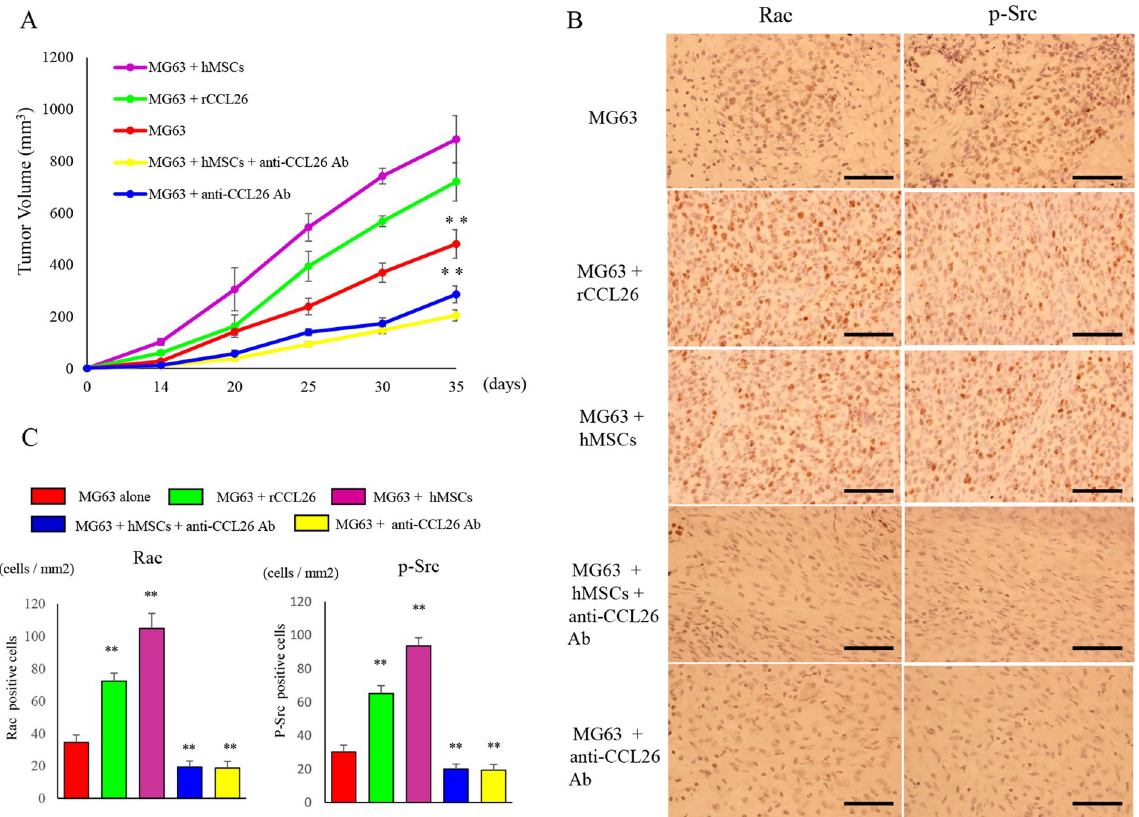
Figure 6. Changes in the lung nodules and the expression of Rac and phosphorylated Src in pulmonary metastatic lesions. ( A ) The group given anti-CCL26 Ab showed a significant suppression of the size of the pulmonary metastatic lesion. ( B ) Immunostaining of the tissues collected from the pulmonary metastatic lesion. Decreased expression of Rac and p-Src was observed in the group administered anti-CCL26 Ab. Original magnification, × 400; Scale bars: 50 μm. ( C ) The number of Rac and p-Src positive cells per unit area. Data represents represent the mean ± SD of three independent experiments. p < 0.05 was considered to indicate significance: (*) p < 0.05, (**) p <